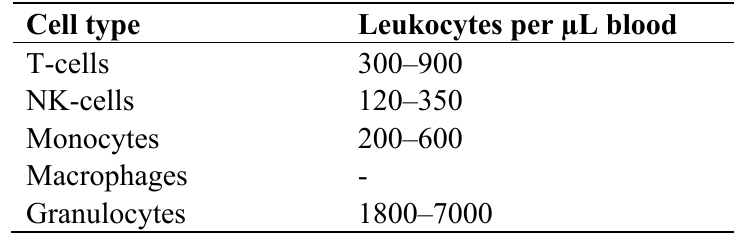
Table 3. Numbers of different classes of human leukocytes in healthy